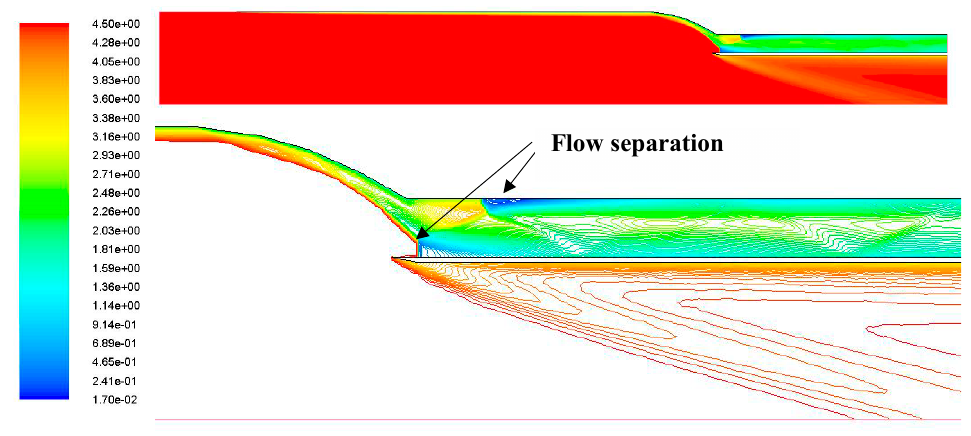
Figure 21. Mach contours of four ramp inlet at Mach 4.5.